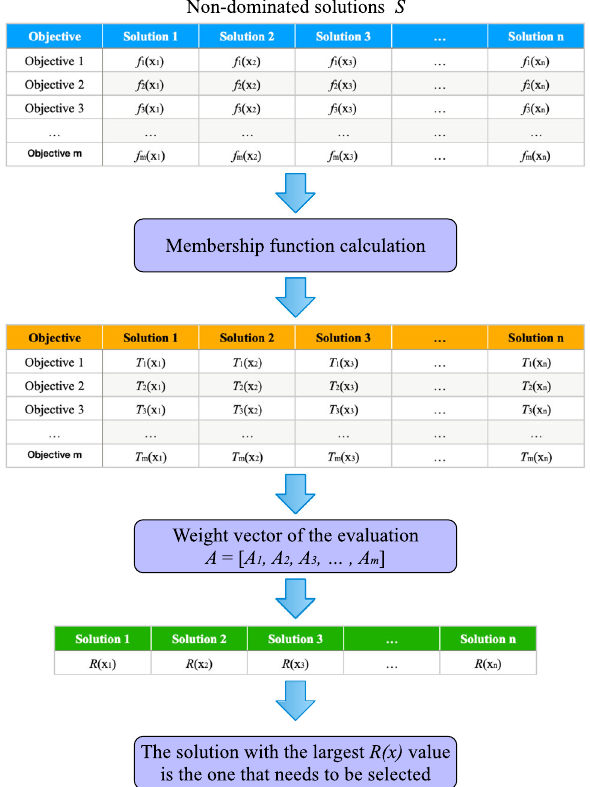
Fig. 6 Specific steps of decision filtering mechanism